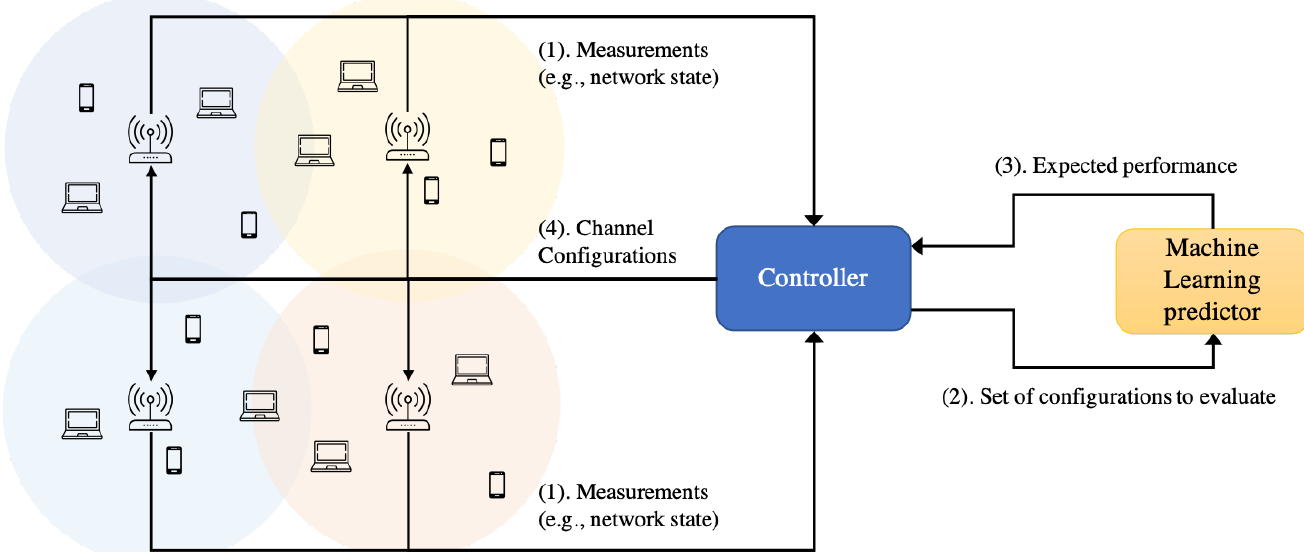
Figure 11. Usage of ML predictors for network